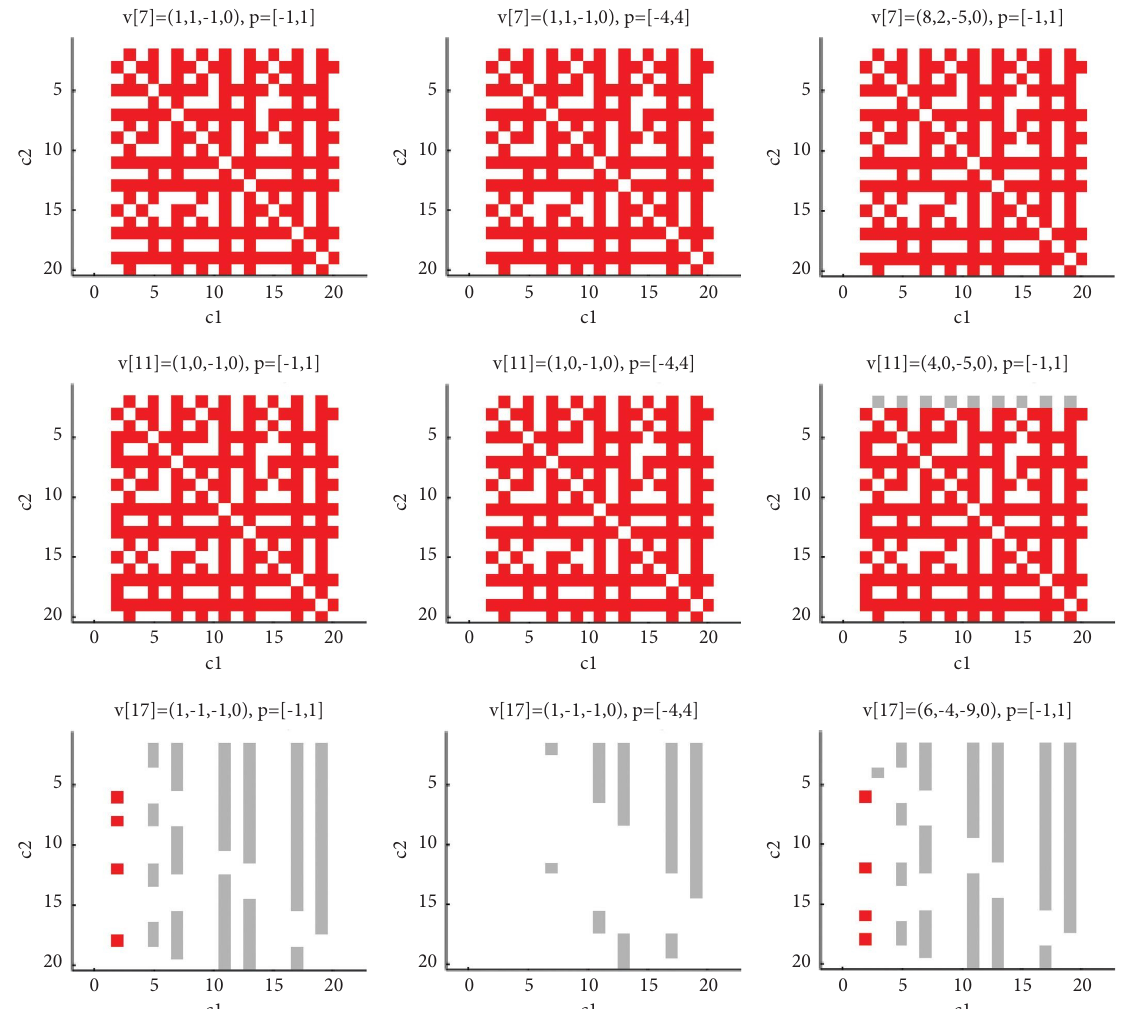
Figure 2: Attractors for tuples v , v and v from Proposition 1. Te tuples are of a “competition” type. Global fxed points for v 7 11 17 , c ) � 1. In v are those with gcd ( c , the species C has a behavior like periodic cicadas with prime number fxed points. In this case, the 1 2 17 1 ( c ,c ) is always negative. Attractors are marked with red squares if both species survive and with species C disappears, since the ftness F 2 2 1 2 gray squares if one of the species